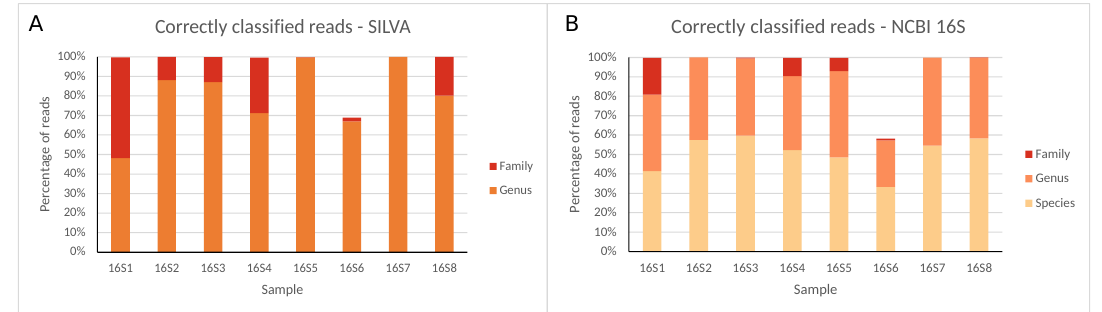
Figure 2. Correctly classified reads for all 16S rRNA gene regions at different taxonomic levels using the ( A ) SILVA and ( B ) NCBI 16S databases for Illumina MiSeq data. Percentages are expressed against the total number of reads classified at any taxonomic level (SILVA only allows classification until the